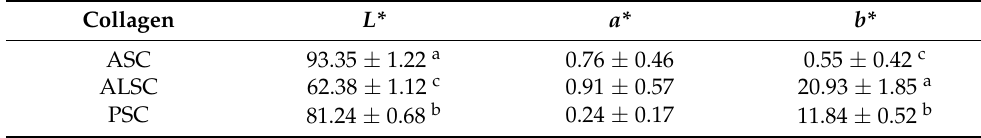
Table 5. Color of chicken collagen extracted by acid, alkali, and enzyme.